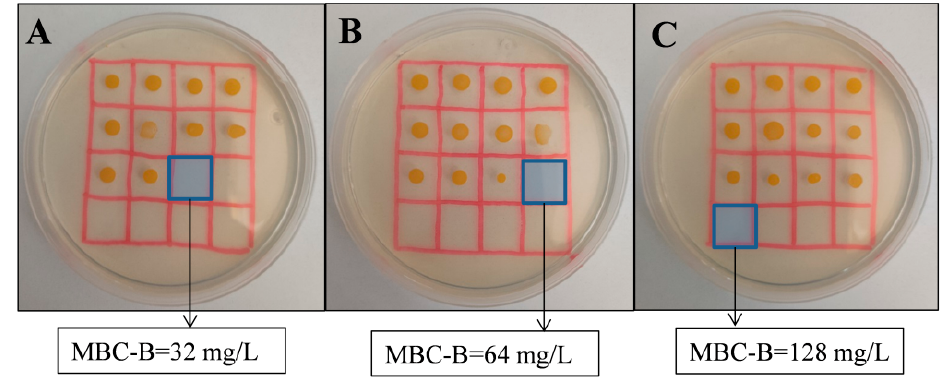
Metallodendrimer Counterion